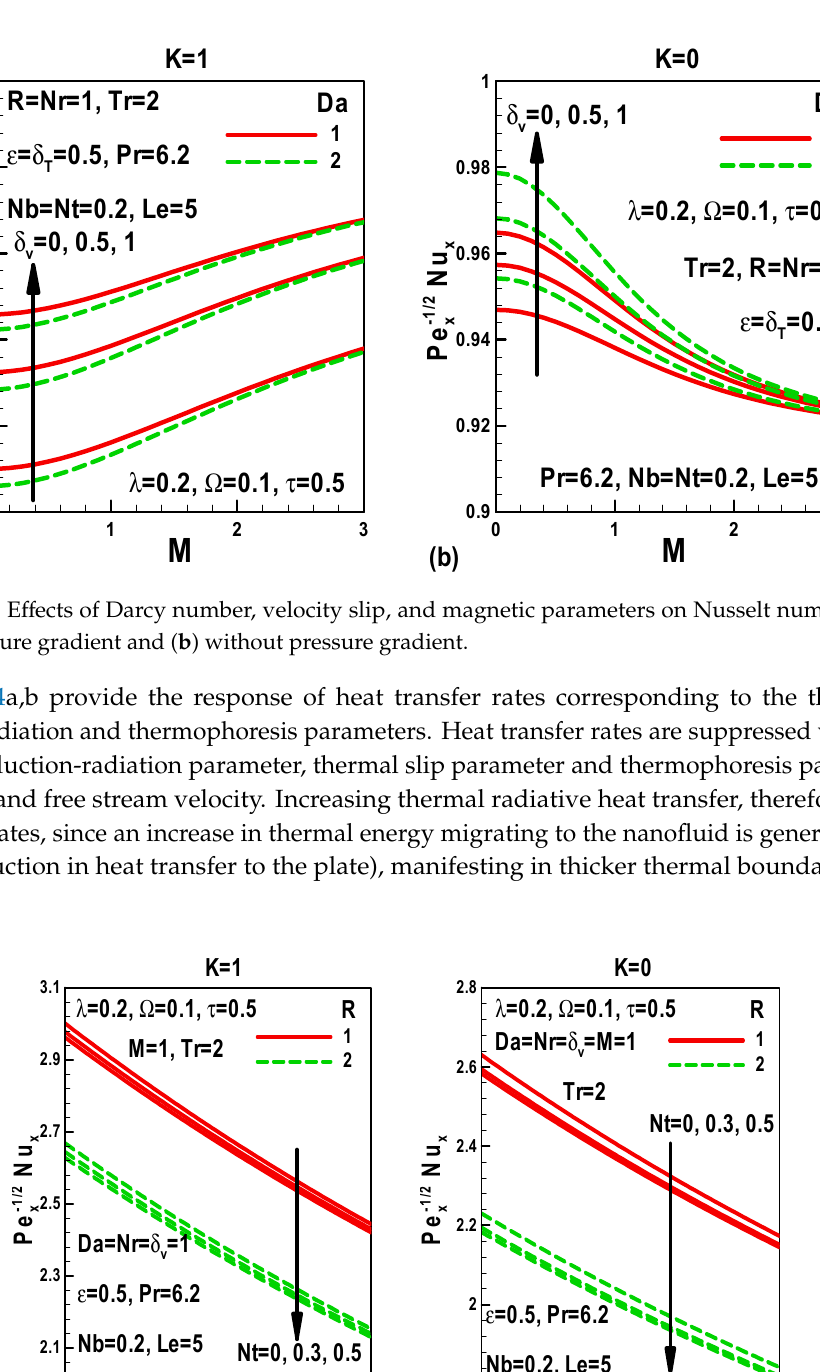
Figure 12. Effects of dimensionless time, frequency, and mixed convection parameters on Nusselt numbers ( a ) with pressure gradient and ( b ) without pressure gradient.